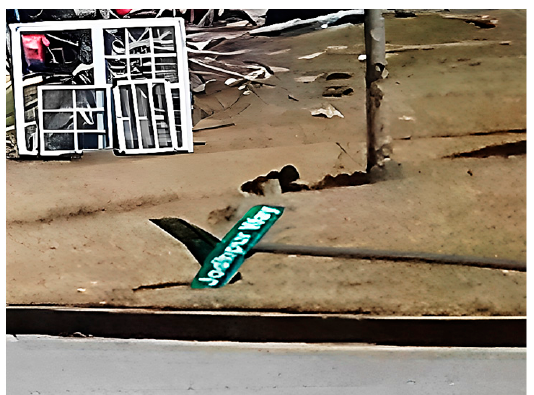
Figure 16. Analyzed road sign. Photo taken after destruction [Foto made by authors of the article].